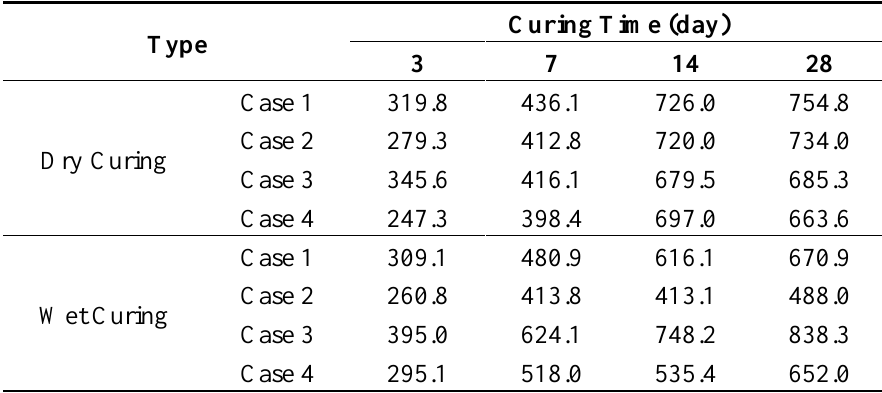
Table 4. Unconfined compressive strength